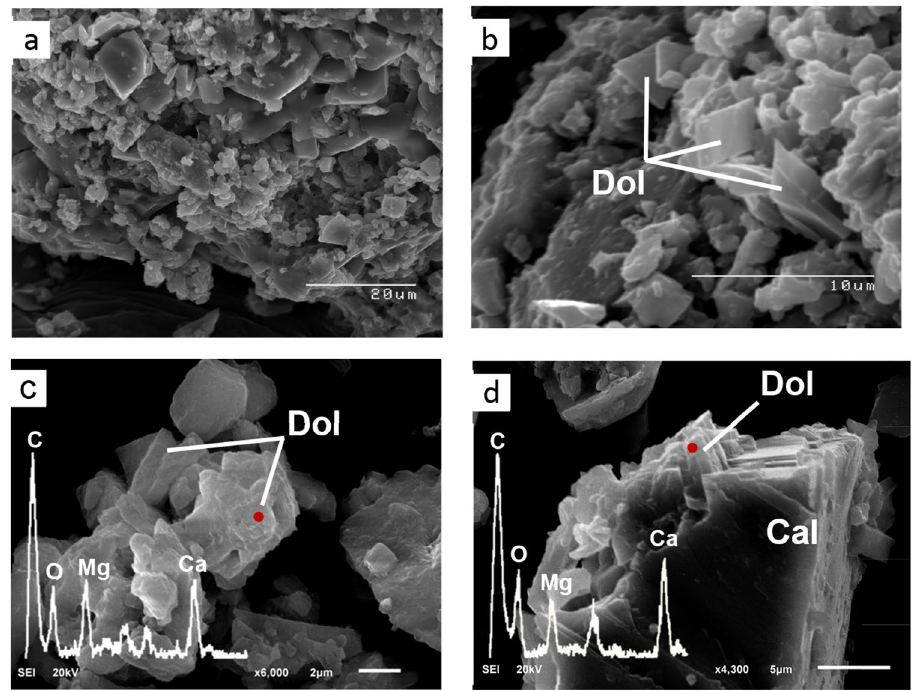
Figure 11. Scanning electron images of authigenic carbonate. ( a ) carbonate matrix represents microcrystals of rhombic dolomite. ( b ) rhombohedral dolomite with soft faces and well-defined edges. ( c ) Dolomite crystals with rough faces. ( d ) Intergrowth of rhombohedral dolomite and calcite showing dolomite precipitation at the expense of calcite dissolution. EDS spectra of single point analysis ( c ) and ( d ) are of the red points. Peaks of Os, Na, Cl, and Si in the spectra were not labeled.